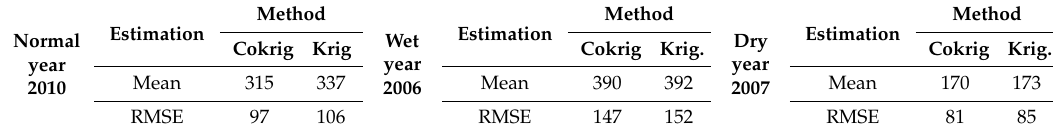
Table 5. RMSE of the best method for estimation of precipitation in dry, wet, and normal